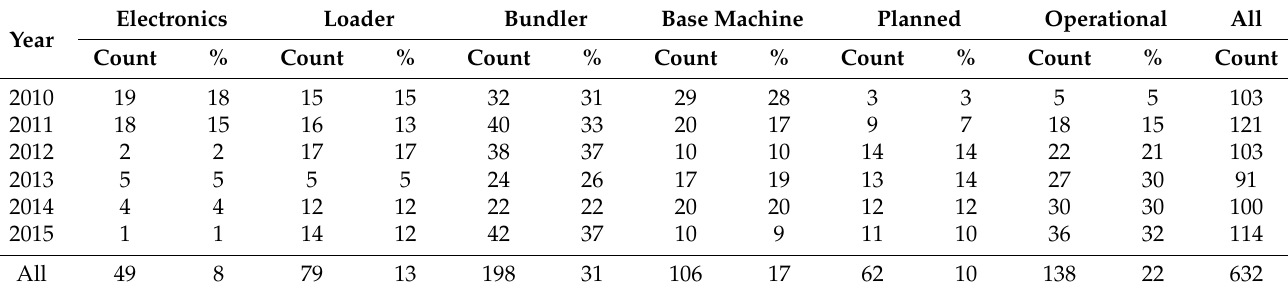
Table 5. Downtime events by year and attribution.